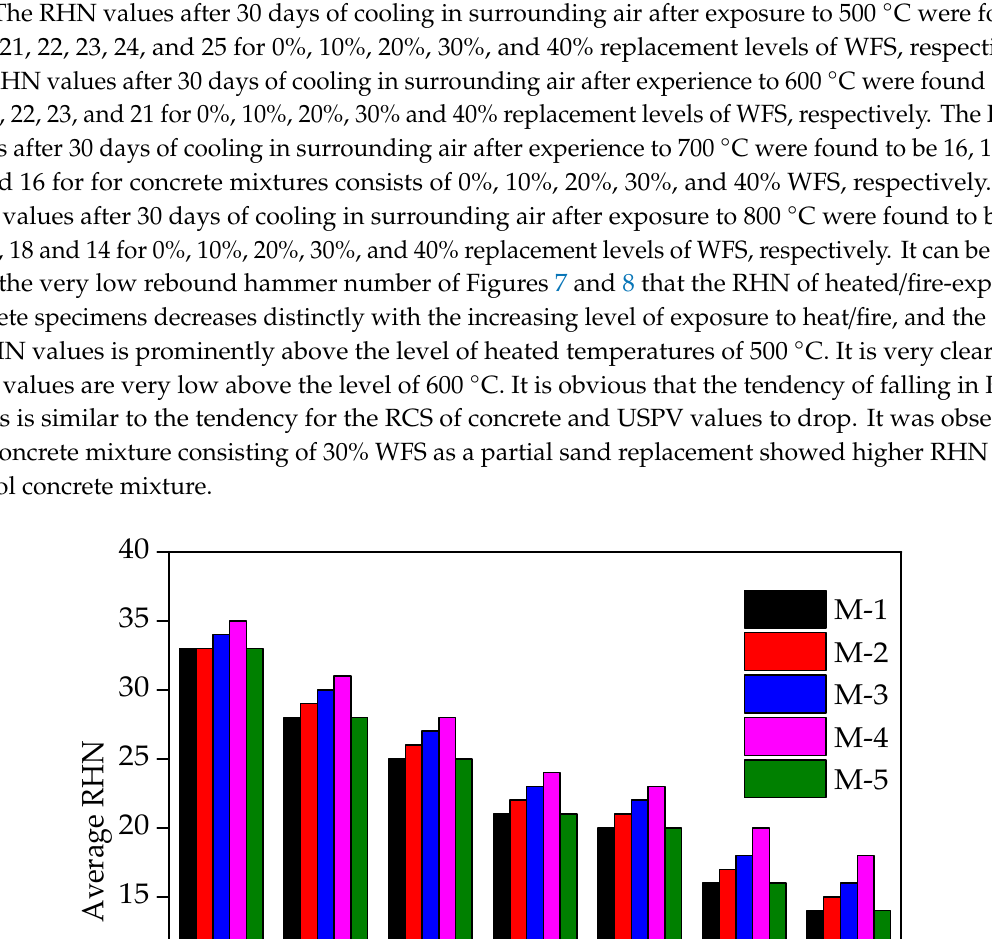
120.00 80.00100.00